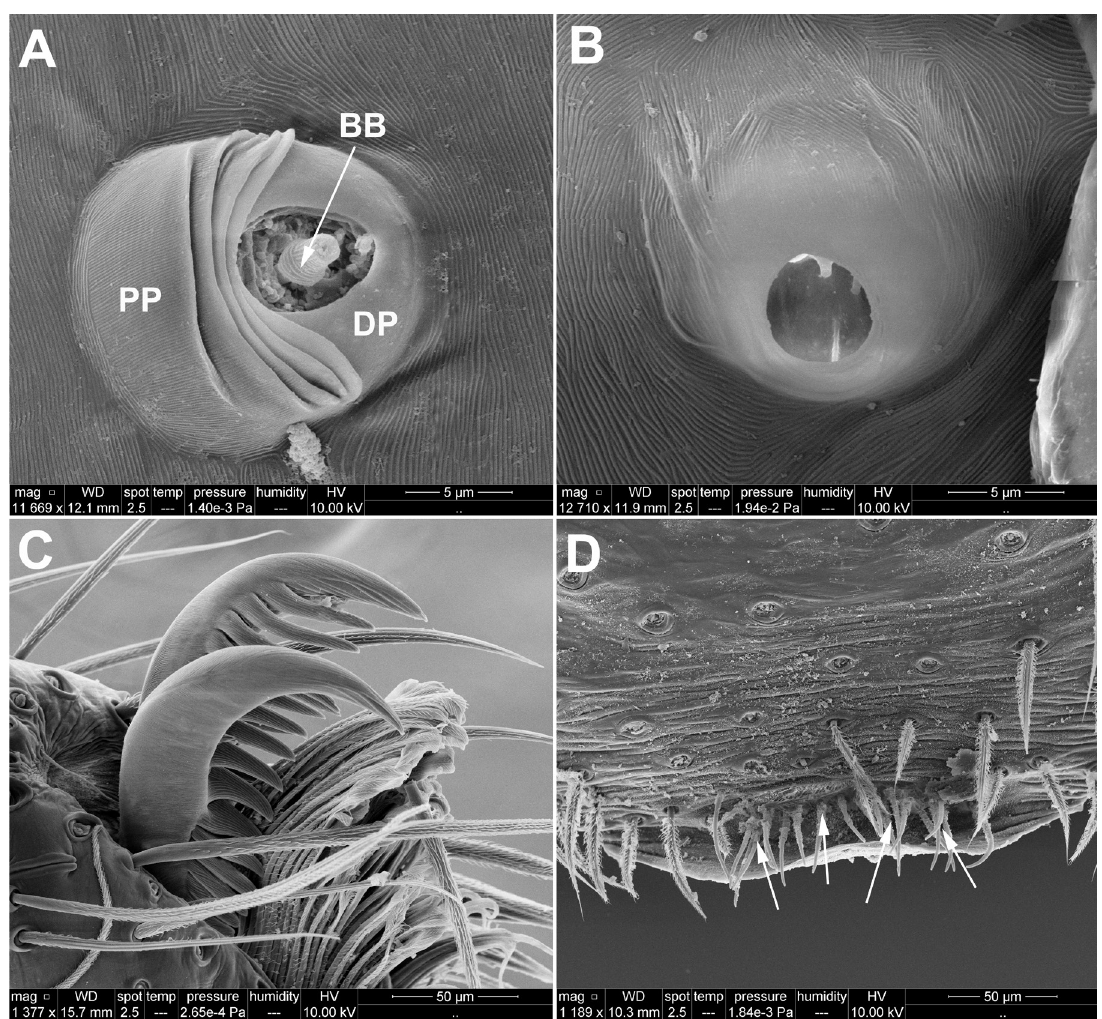
Fig. 2. A − C . Cuiambuca vacabrava sp. nov., holotype, ♂ (IBSP 60013). D . Cuiambuca aratangi sp. nov., holotype, ♂ (IBSP 167826) A . Leg I, tarsus, tricobothria, dorsal view. B . Leg I, tarsus, tarsal organ. C . Leg I, tarsus, claws, prolateral view. D . Epiandrium, epiandrous spigots (arrows). Abbreviations: BB = basal bulb; DP = distal plate; PP = proximal